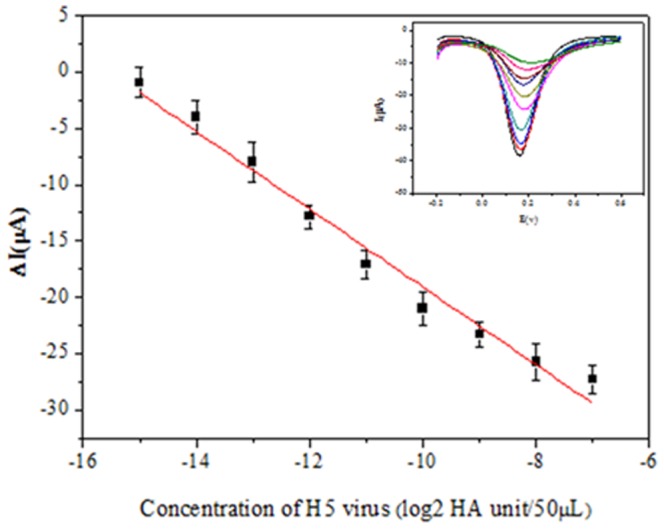
The relationship between antigen concentrations and the sensor response to current.Inset: DPV of the GO-PAb-BSA modified immunosensor with various concentrations of H5 (from top to bottom: 0, 2−15, 2−14, 2−13, 2−12, 2−11, 2−10, 2−9, 2−8, and 2−7 HA unit/50 µL, in pH 7.0 PBS containing 5 mM K4Fe(CN)6, 5 mM K3Fe(CN)6 and 0.1 M KCl).